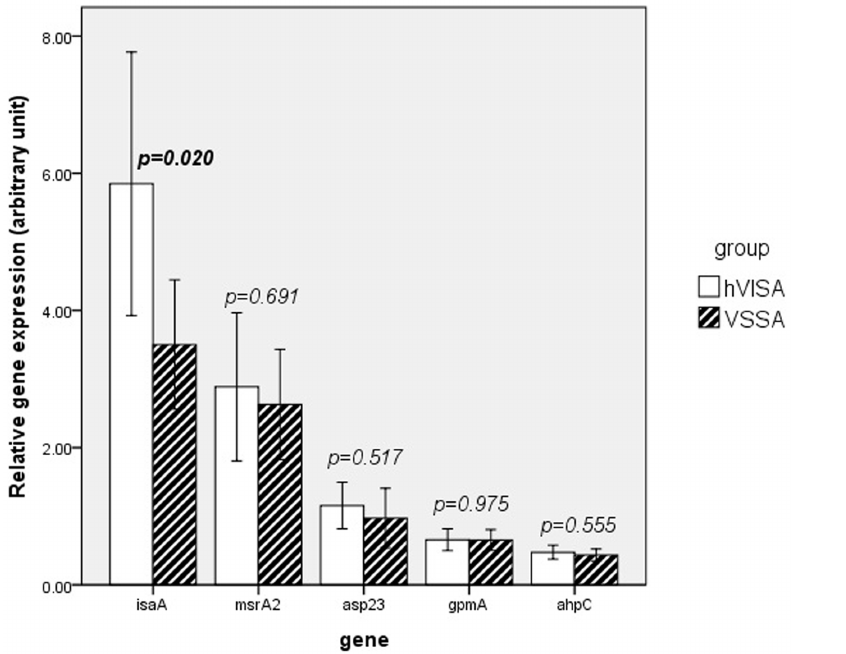
Differentially expressed genes Relative gene expression (arbitrary unit) a